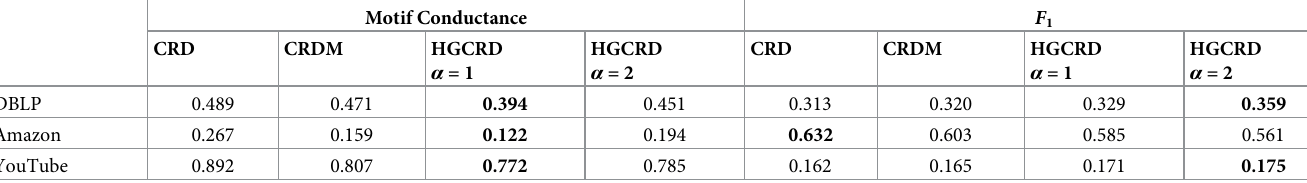
Table 3. Comparison between CRD, CRD-M and HG-CRD using SNAP datasets. Motif